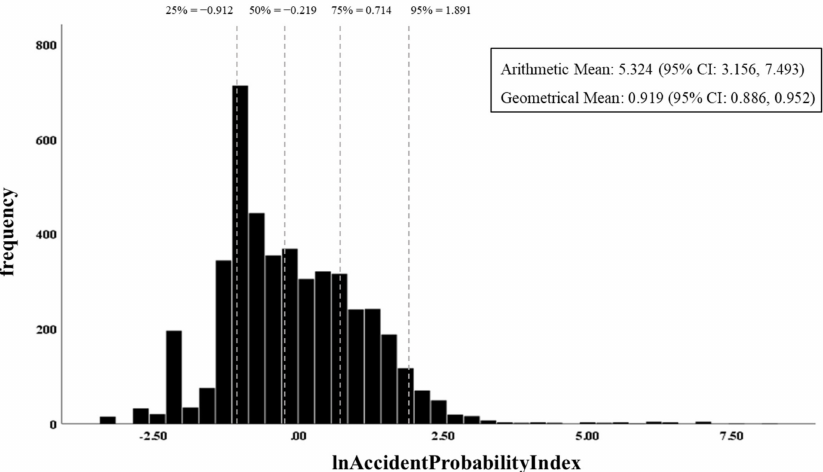
Figure 4. Distribution of accident probability index for 4520 chemical plants.